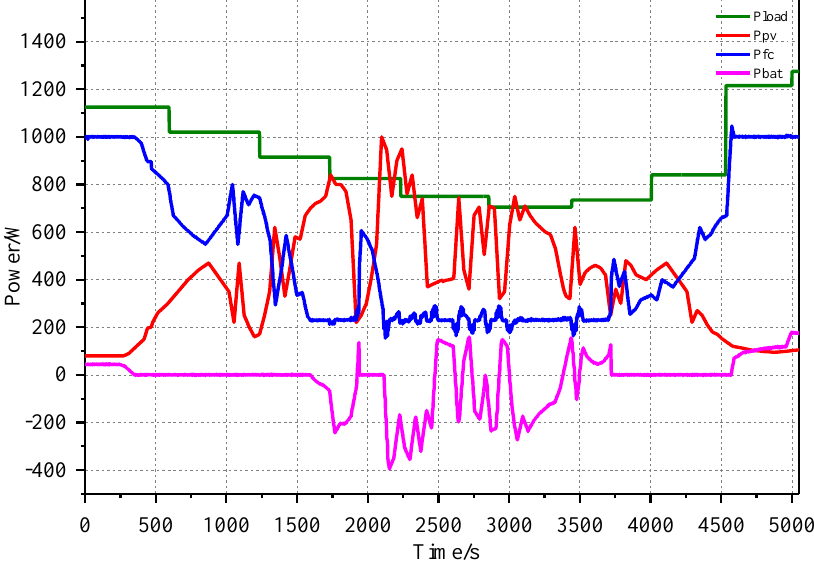
Figure 11. Power flow of the DC microgrid with initial SOC at 60%.